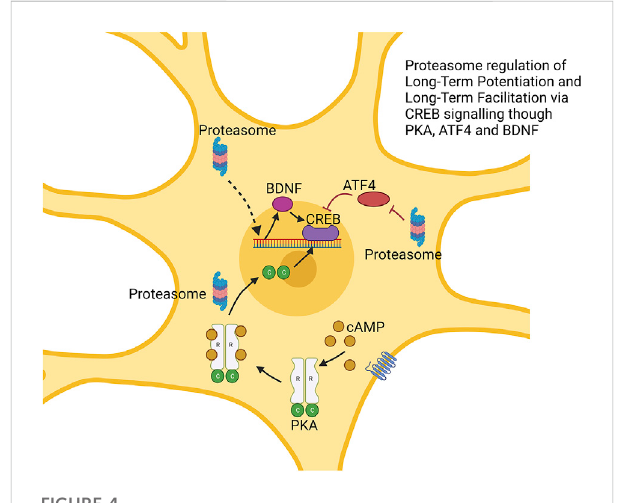
FIGURE 4 Proteasomemodulation oflong-term potentiationviaregulation of CREB signaling. The proteasome regulates multiple factors impacting CREB function. This includes degradation of CREB repressor ATF4. cAMP-induced degradation of the R subunit of protein kinase alpha (PKA) produces free C subunit, which may enhance CREB function. Augmented BDNF expression also enhances CREB function. → is intended to denote causation. ┴ is intended to denote inhibition. ⇢ is intendend to denote causation through a mechanism that is not fully de fi ned. Images Created with